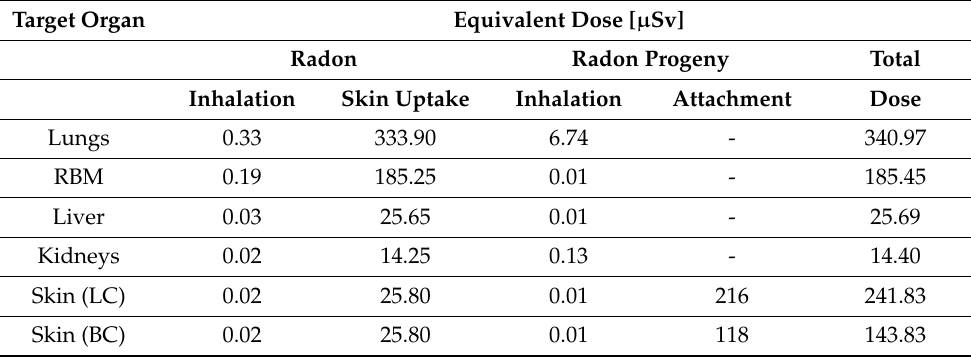
Table 6. Comparison of organ doses received in the thermal bath for different exposure pathways.